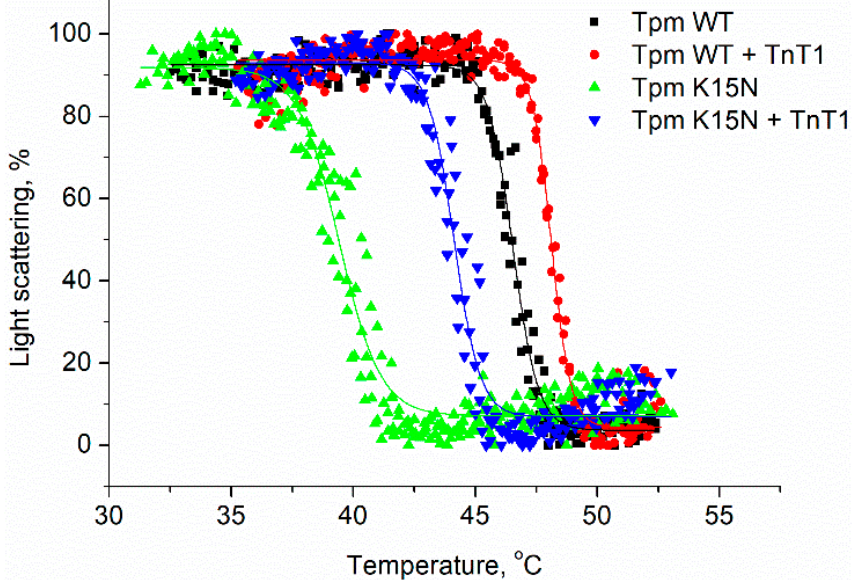
Figure 3. Normalized temperature dependencies of dissociation of the complexes of F-actin with the Tpm WT or Tpm K15N mutant in the absence or presence of TnT1. A 100% value corresponds to the difference between the light scattering of Tpm–F-actin complexes measured at 25 °C and that of pure F-actin stabilized by phalloidin, which was temperature-independent within the temperature range used. T diss values for WT Tpm and Tpm mutants are presented in Table 1.